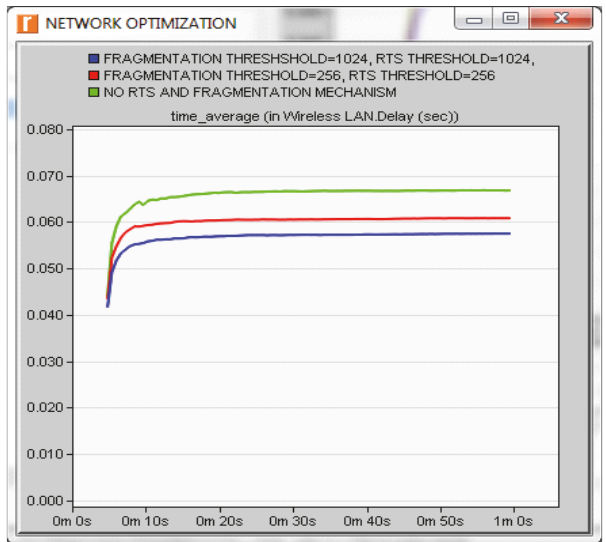
Figure 23: WLAN delay optimization with different values of RTS and fragmentation thresholds.